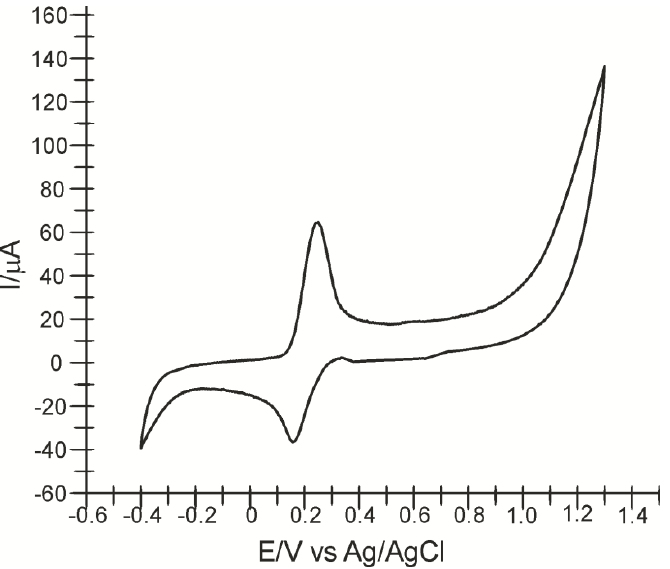
Figure 2. Cyclic voltammogram CNF/SPE immersed in 10 − 3 M caffeic acid solution (0.1 M PBS pH = 7.0) at 0.1 V·s − 1 .